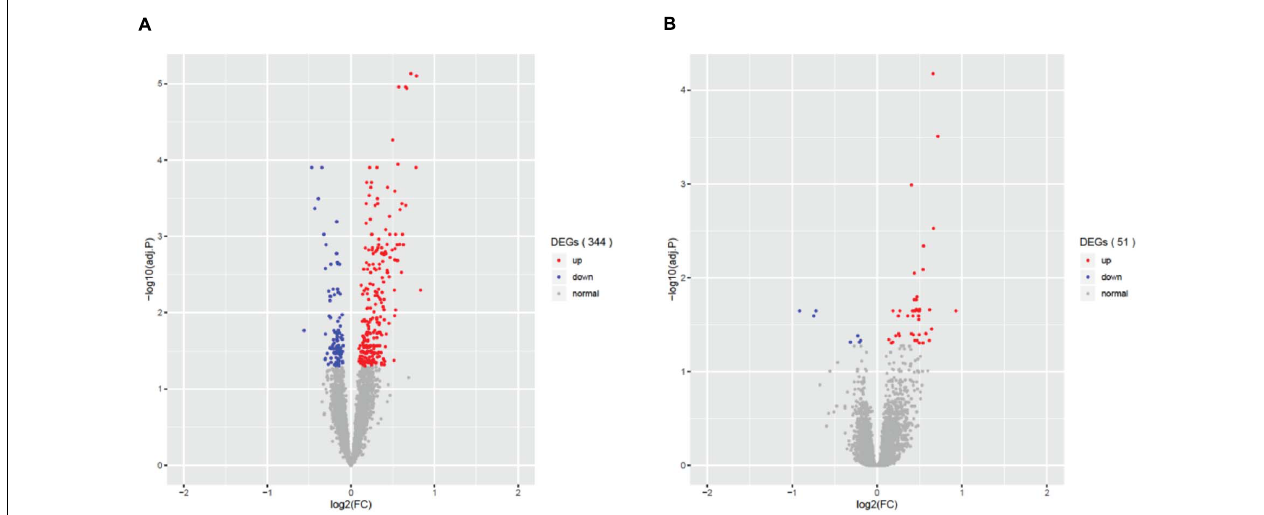
FIGURE 1 | Differential expressed genes (DEGs) associated with the agonal factors of fever (A) and infection (B) . In total, 344 significant DEGs were associated with agonal fever, and 51 significant DEGs were associated with infection.